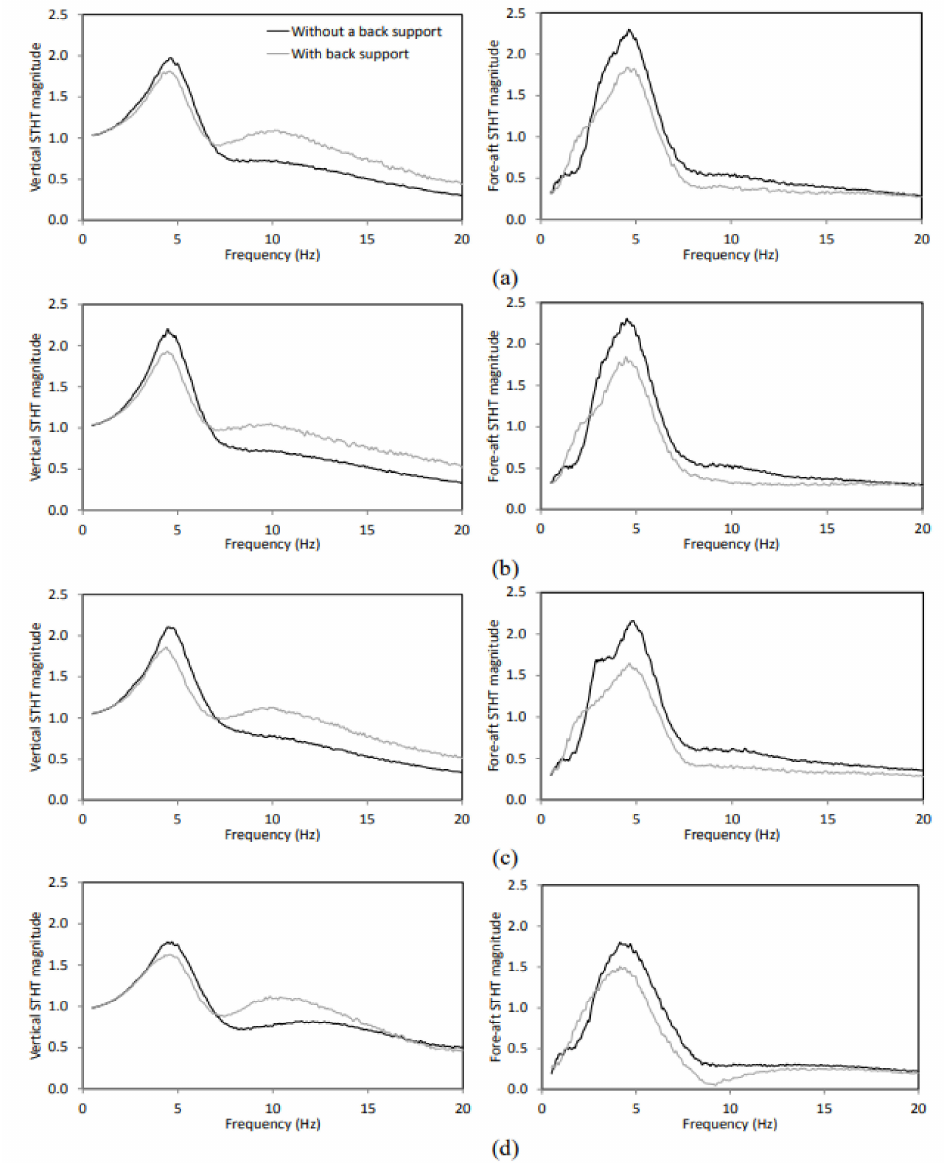
Figure 8. Mean STHT magnitudes of 58 participants seated with and without back support under 0.50 m/s 2 RMS excitation: ( a ) seat A; ( b ) seat B; ( c ) seat C; and ( d ) rigid